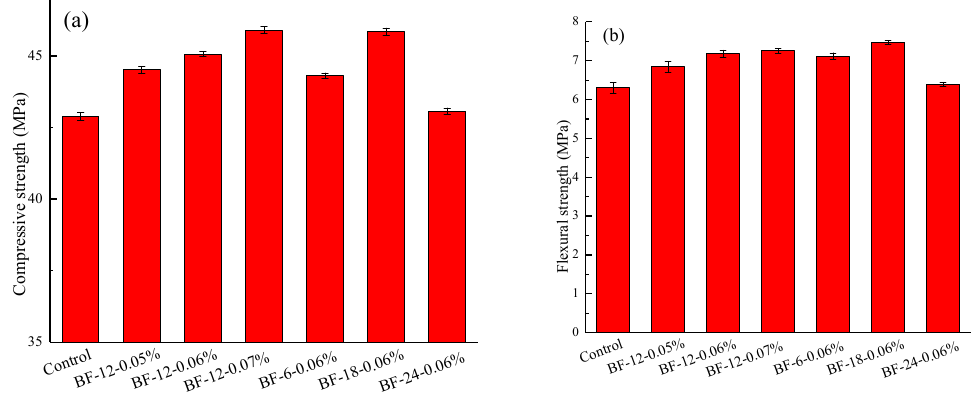
Figure 11. Strength of control concrete and BFRCs: ( a ) Compressive strength ( b ) Flexural strength).